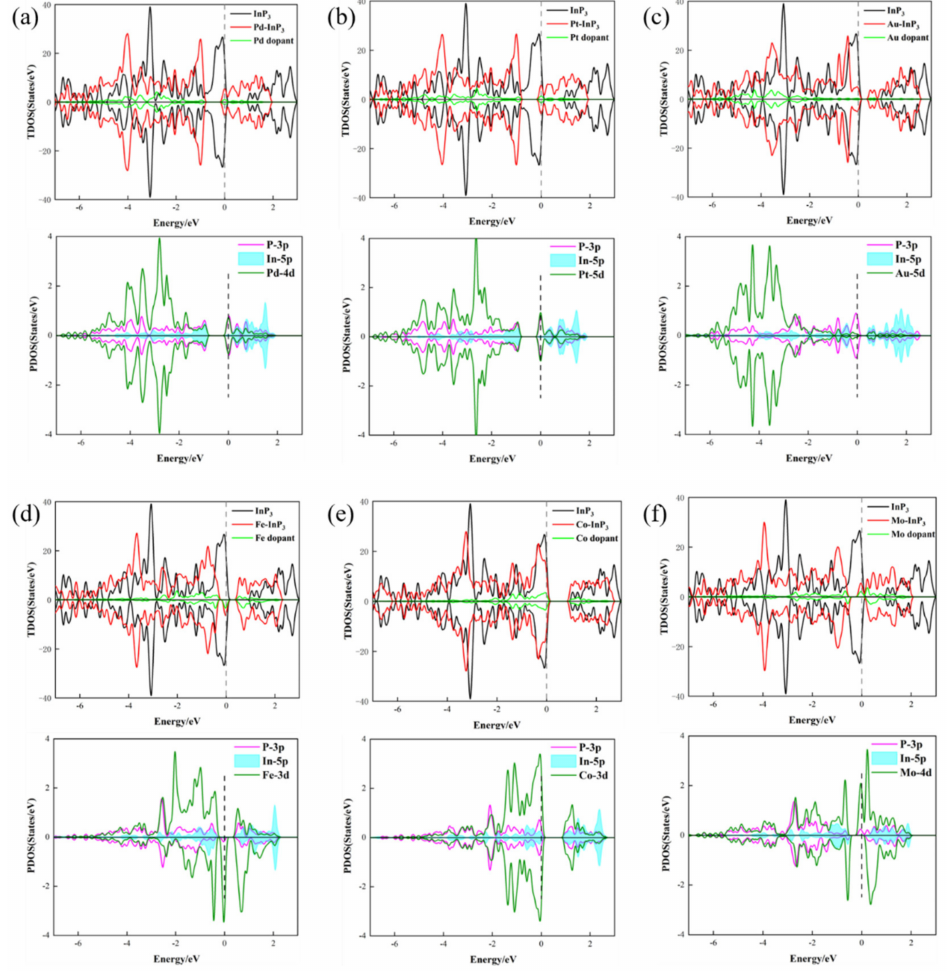
Figure 3. DOS of ( a ) Pd-InP 3 , ( b ) Pt-InP 3 , ( c ) Au-InP 3 , ( d ) Fe-InP 3 , ( e ) Co-InP 3 and ( f ) Mo-InP 3